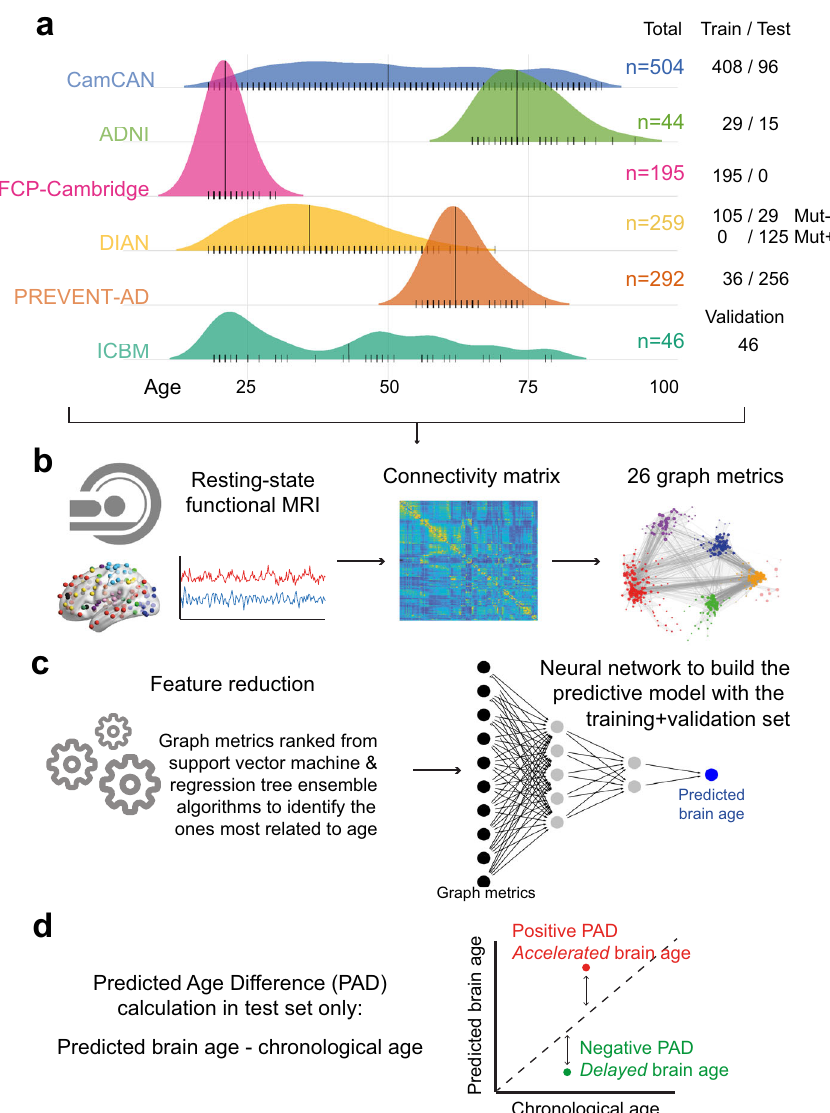
Fig. 1 Methodology overview. a Multiple cohorts covering the lifespan were included in the study. They were separated into a training and validation set, both used to develop the predictive brain age model, and a test set in which our model was applied. b All participants underwent resting state functional magnetic resonance imaging that was processed with a uniform pipeline. Functional connectivity matrices were generated from the Power atlas 82 , from which graph metrics were calculated. Graph metrics were the input in our brain age model, and thus all possible metrics were of interest. c The fi rst step toward building the model was to rank the different graph metrics from the most to least related to aging in our training set, to determine an order of importance to our model inputs using both support vector machine and regression tree ensemble algorithms. Neural networks were then tested to identify the best brain age model. Different architectures were tested, and the model applied in the training set that best generalized to the validation set